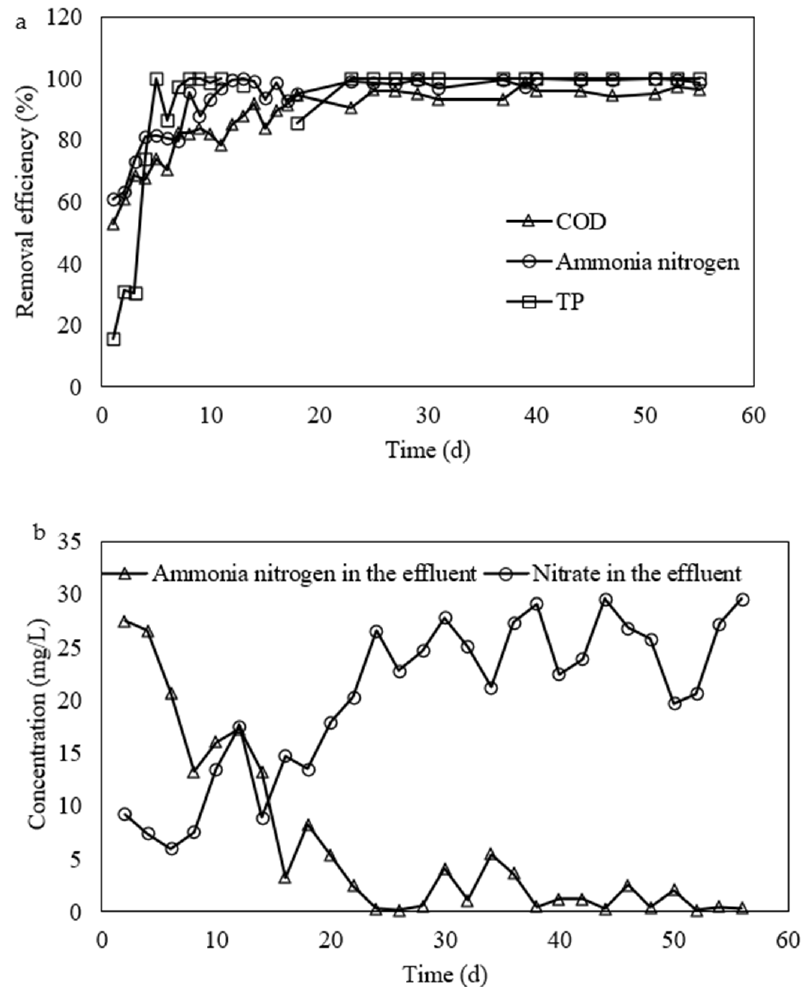
Figure 2. Pollutant concentration variation and removal efficiency. ( a ) the pollutant removal efficiency; ( b ) concentration variation of ammonia and nitrate in the effluent.